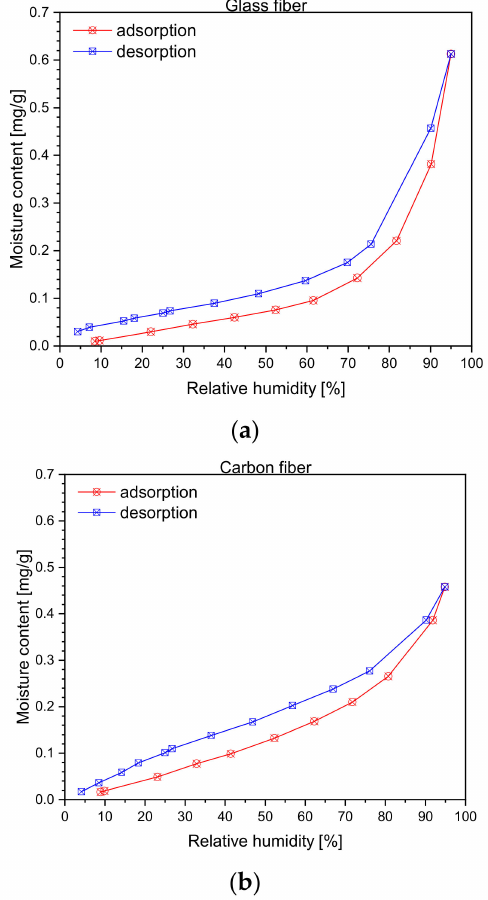
Figure 3. Sorption isotherms at 23 ◦ C of ( a ) glass fiber PD-I 92125 FK800 and ( b ) carbon fiber Zoltek